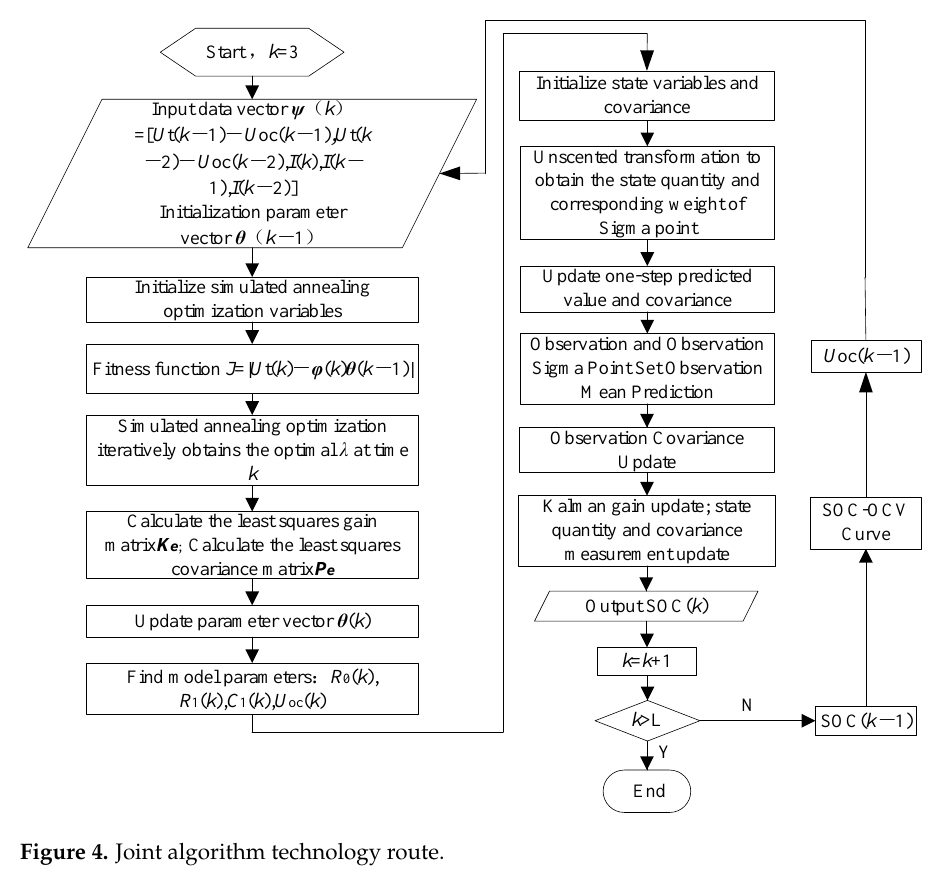
Figure 4. Joint algorithm technology route.